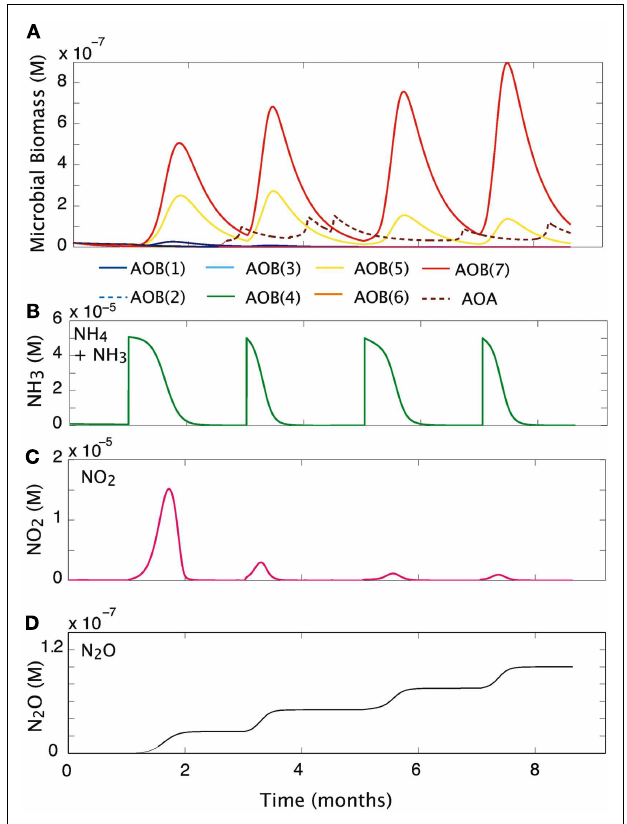
FIGURE 5 | Community response to pulsed substrate input. (A) Changes in AOO biomass over time. (B) Substrate concentration (M). (C) Nitrite dynamics over time. (D) Production of N 2 O over